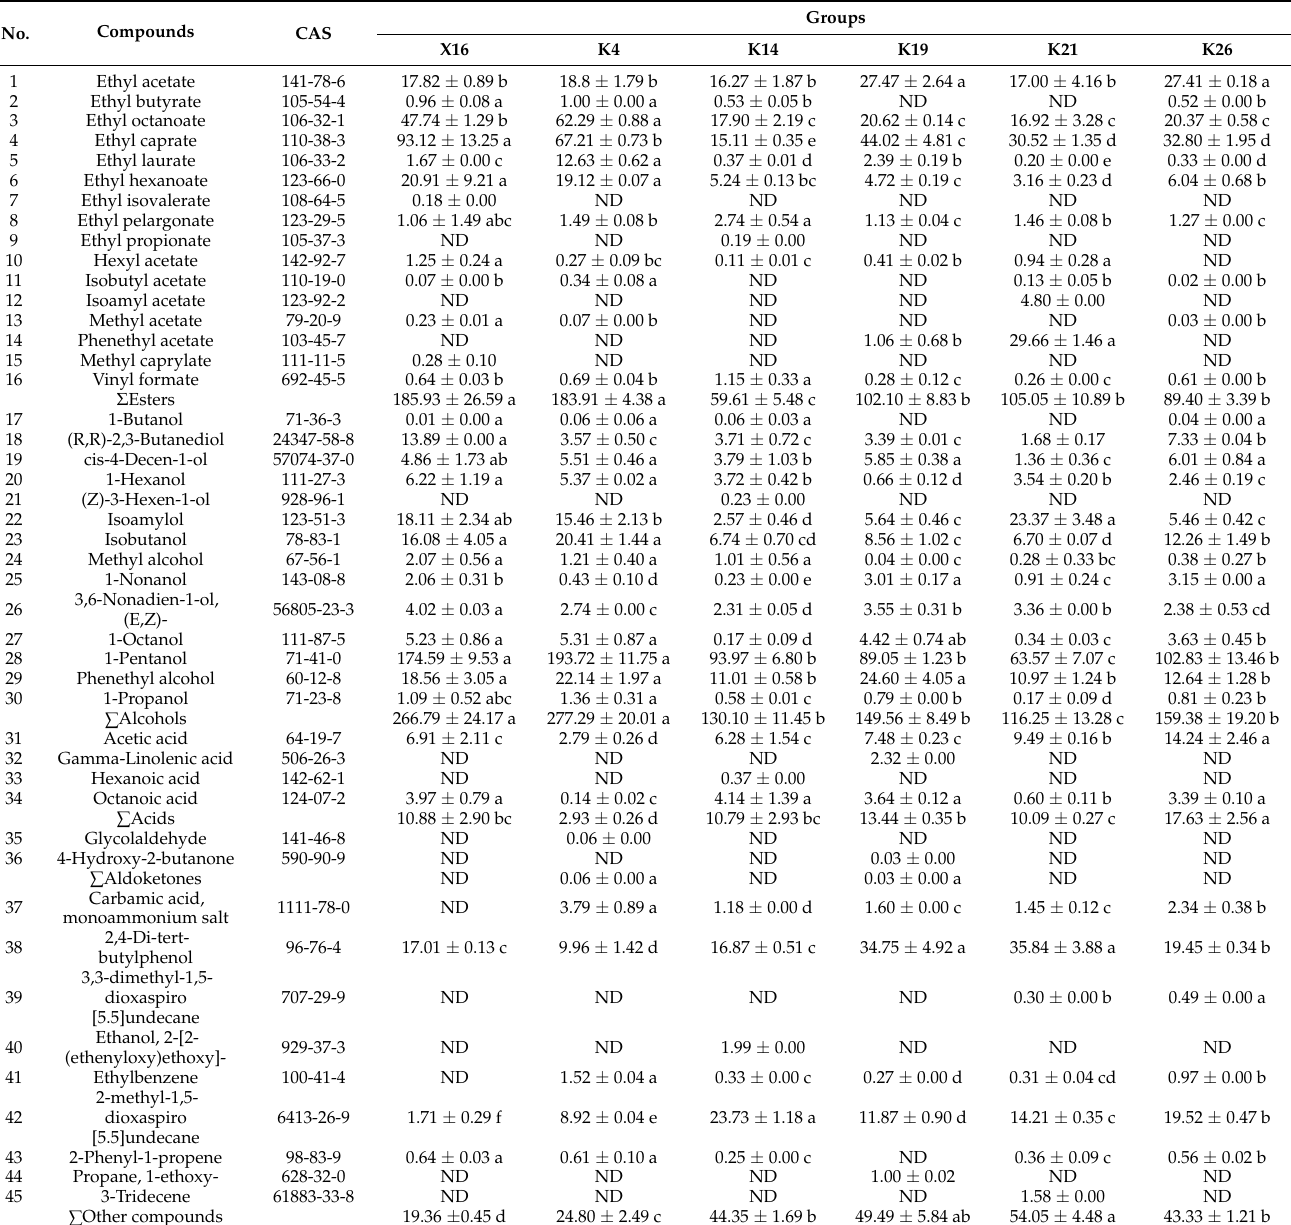
Table 4. Volatile compounds (mg/L) in KFP wines fermented with different